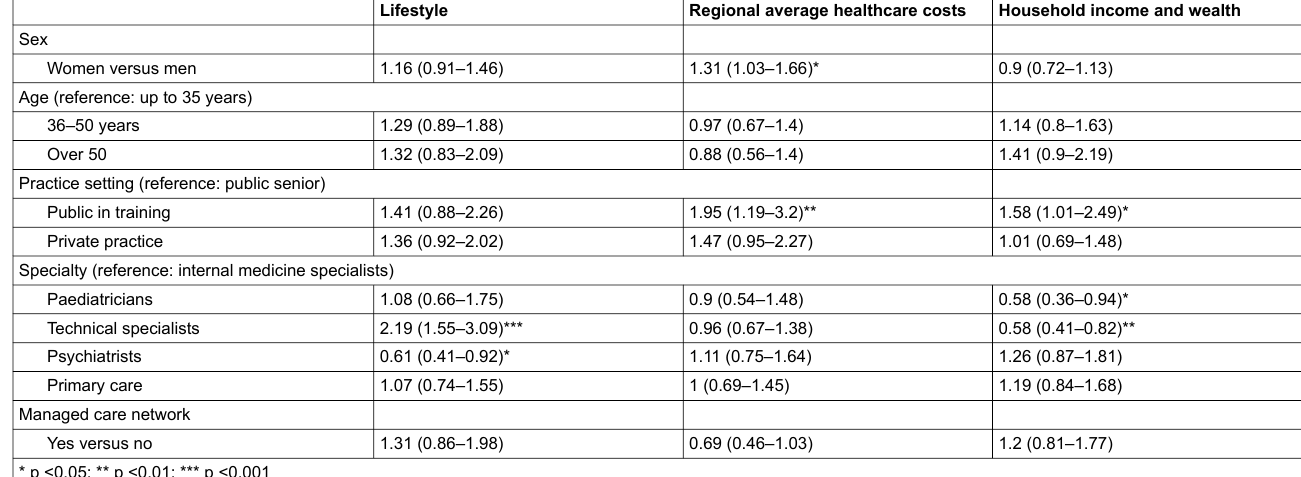
Table 3: Odds ratios and 95% confidence intervals from multivariate logistic regression of the responses on the use of the items dealing with lifestyle, cantonal average healthcare costs, and household income and wealth in determining compulsory health insurance premiums as dependent variables, and age, sex, practice setting, specialty and involvement in a managed care network as explanatory variables.